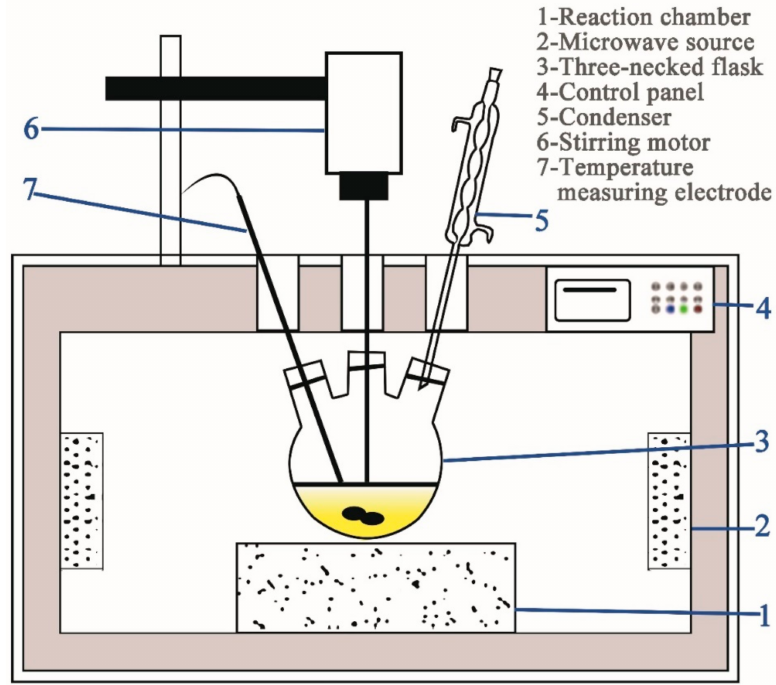
Figure 2. Schematic of the MAS-II Plus atmospheric microwave